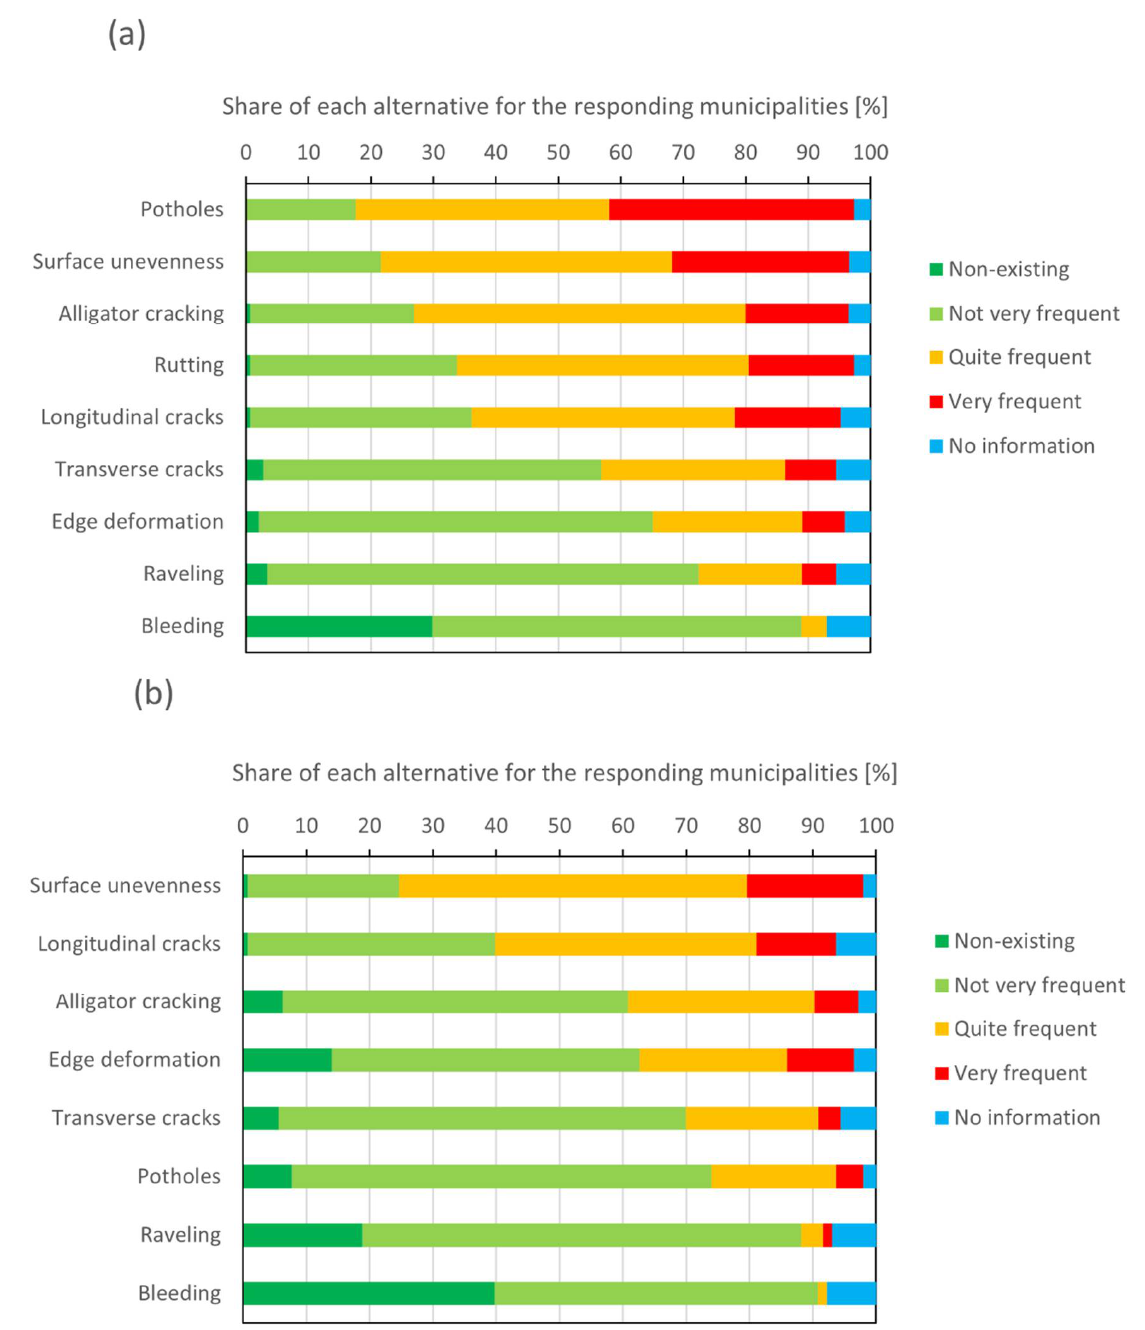
Figure 3. The stated frequency of distress by type on the municipal ( a ) streets and ( b ) cycle path networks, respectively. The response rate varies for the different distress modes and is marginally higher for streets (n = 144–148) than for cycle paths (n = 141–143).